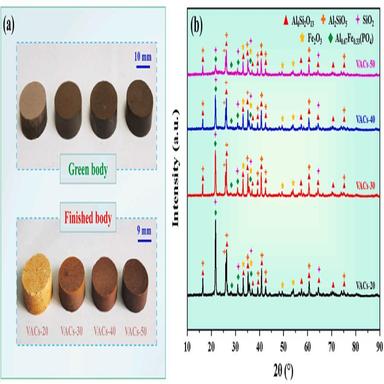
(a) Appearance of VACs with different WTPS additions before and after sintering; (b) Crystalline phase changes of VACs with various WTPS additions sintered at 1400 ℃.